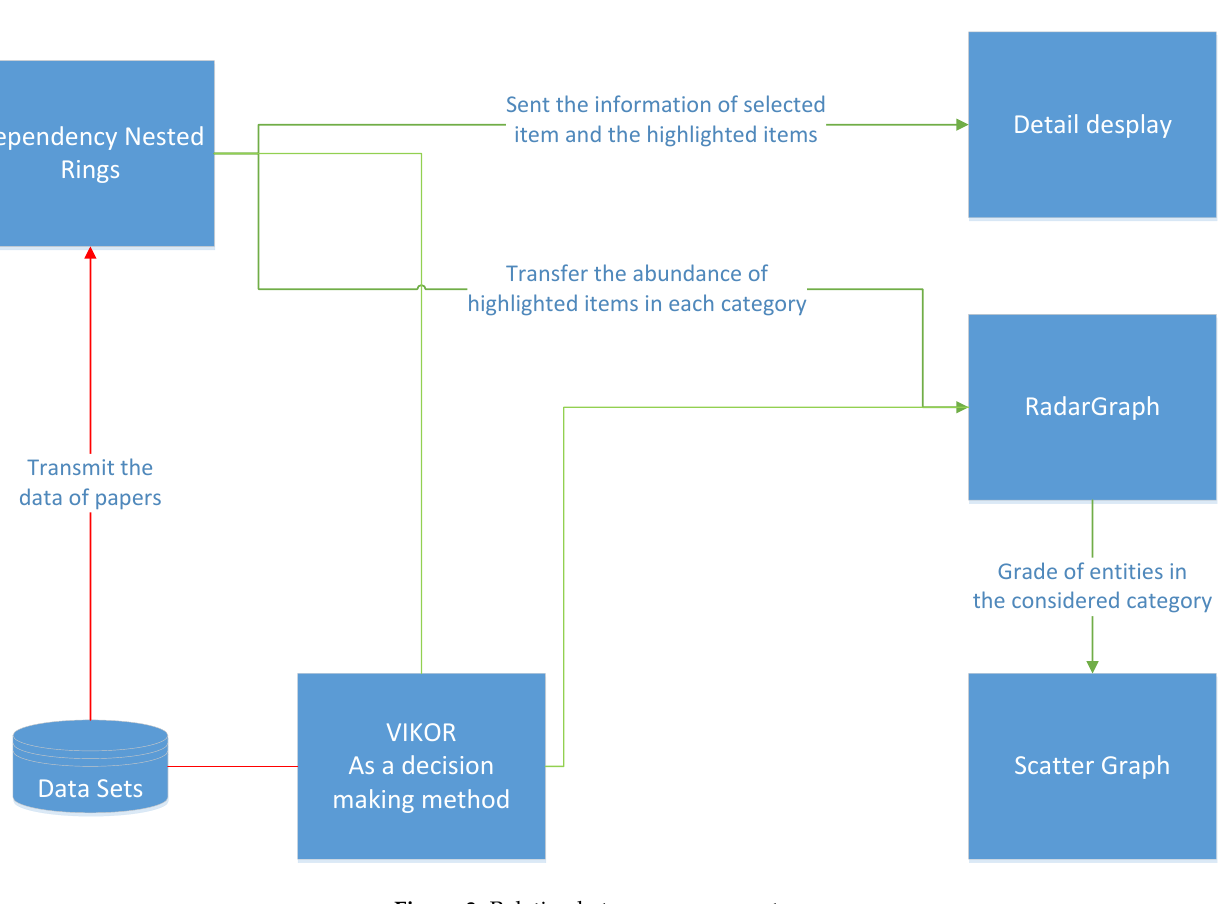
Figure 3. Relation between